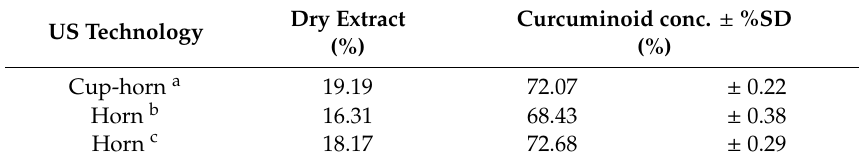
Table 4. US technology